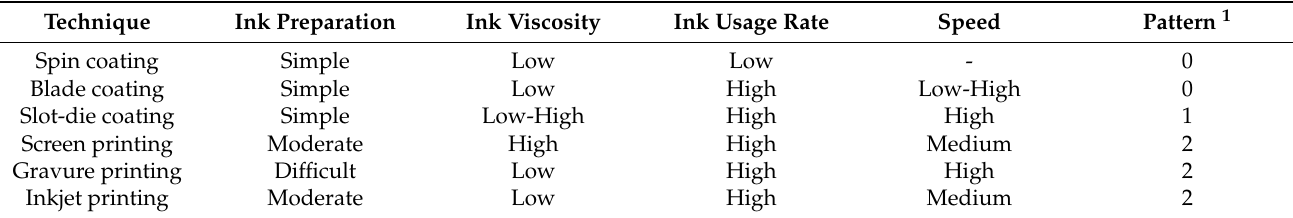
Table 2. The comparison of different fabrication